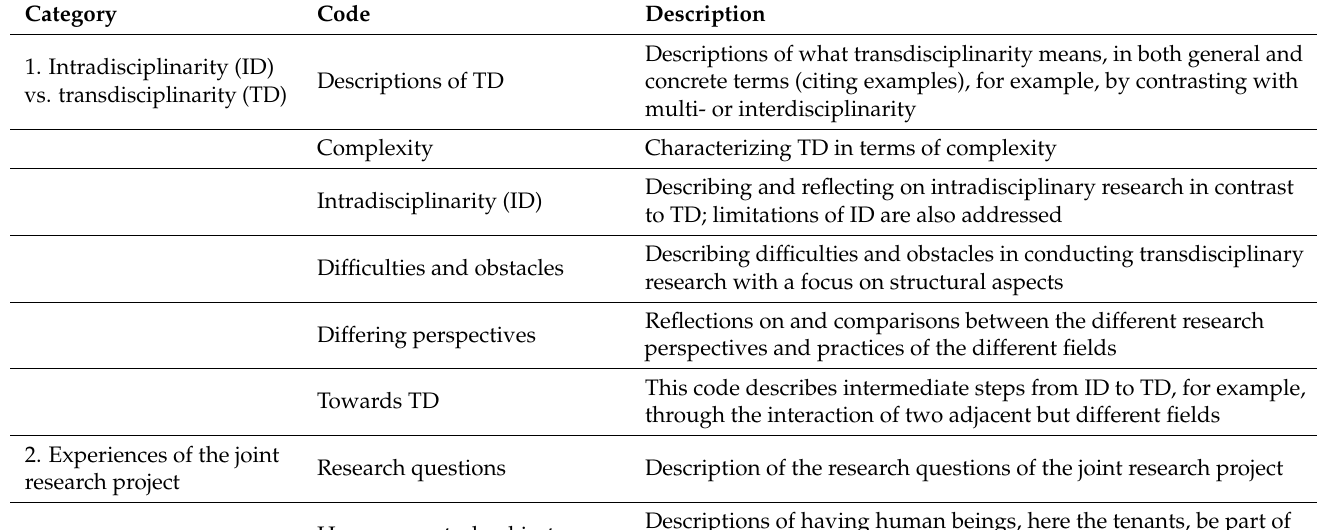
Table 2. Categories and codes used in the analyses of the transcribed